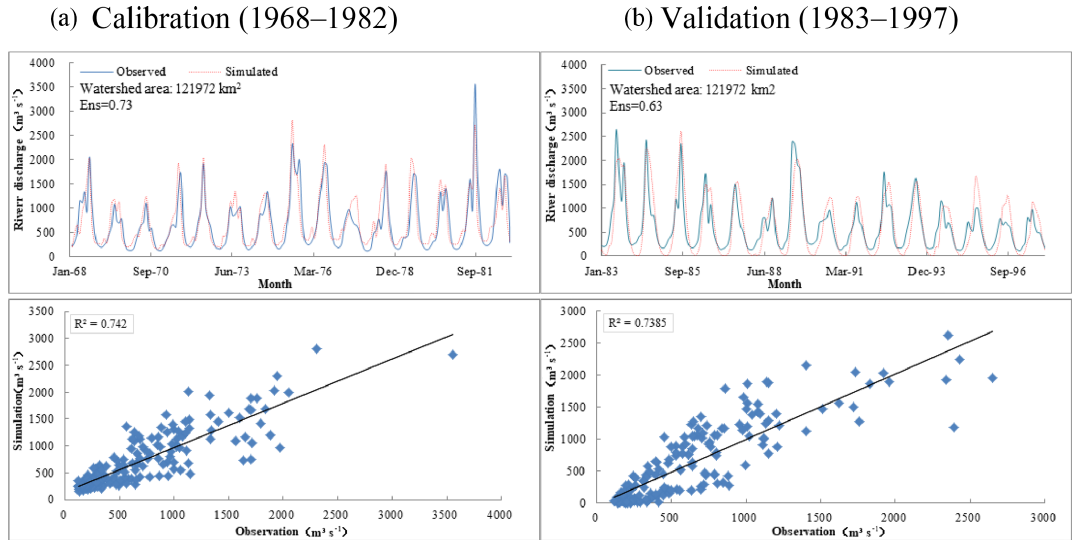
Figure 3. Comparison between the measured and the simulated discharges for Tangnaihai hydrometric station. Calibration (a) and Valida- tion (b) are showed.